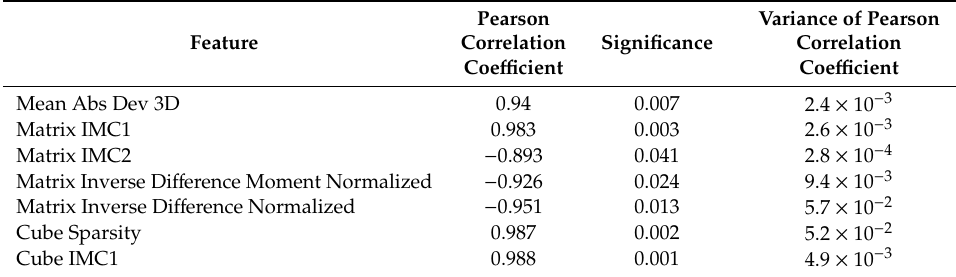
Table 1. Pearson correlation coe ffi cients and significance level for CT-derived imaging features, which exhibit correlation with Ki-67marker.